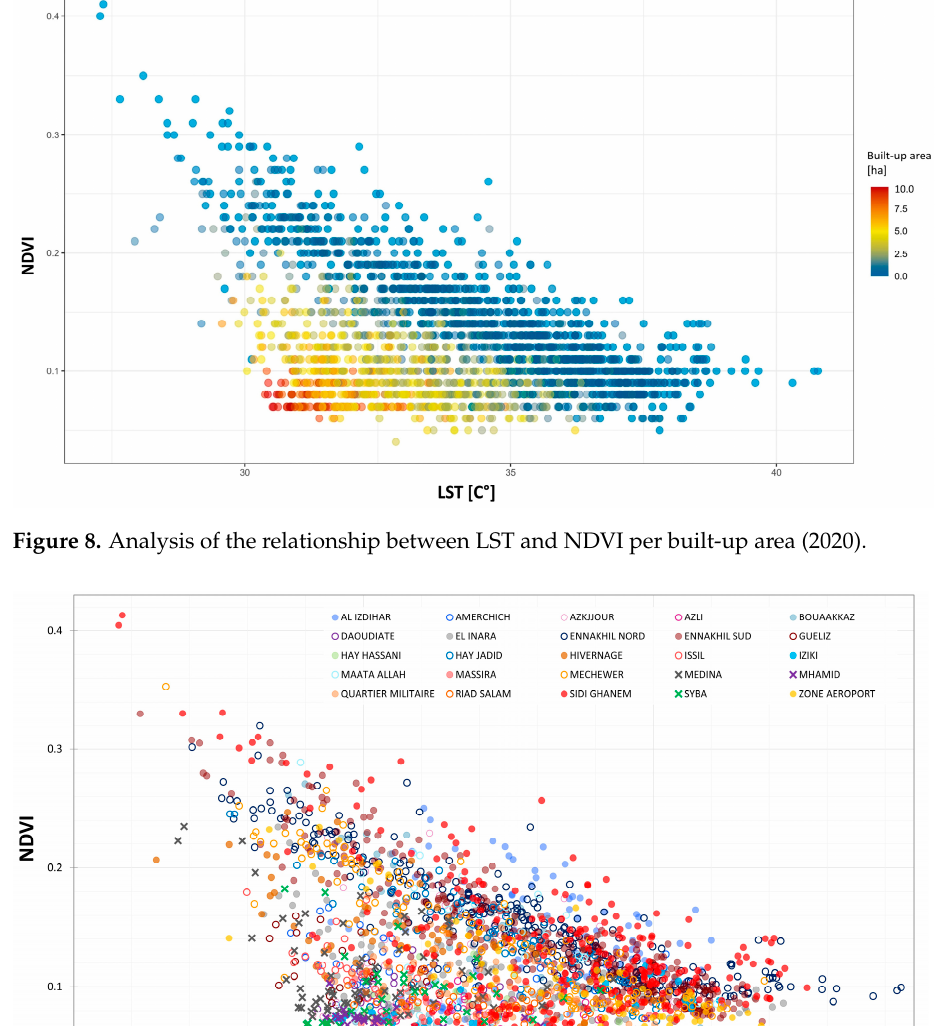
Figure 7. Relationship between LST and NDVI from 1985 to 2020.